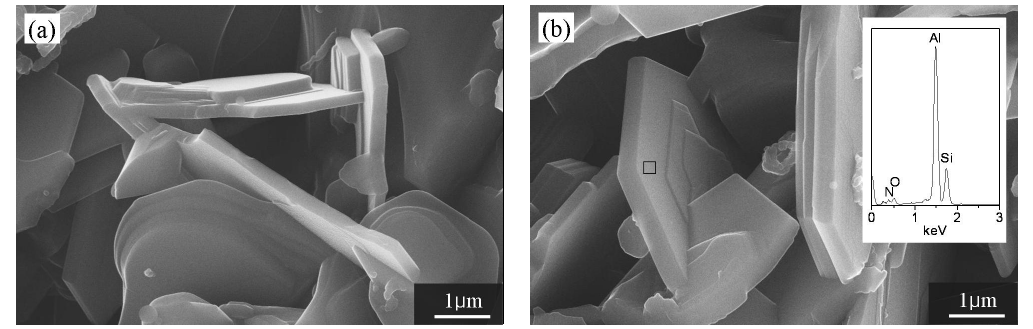
Figure 3. SEM images of fracture surfaces and EDS result of samples H1: ( a ) growing